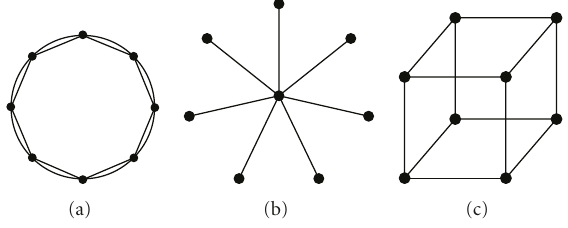
Figure 4: Structured networks: (a) R 8 , (b) S 8 , and (c) H 8 .